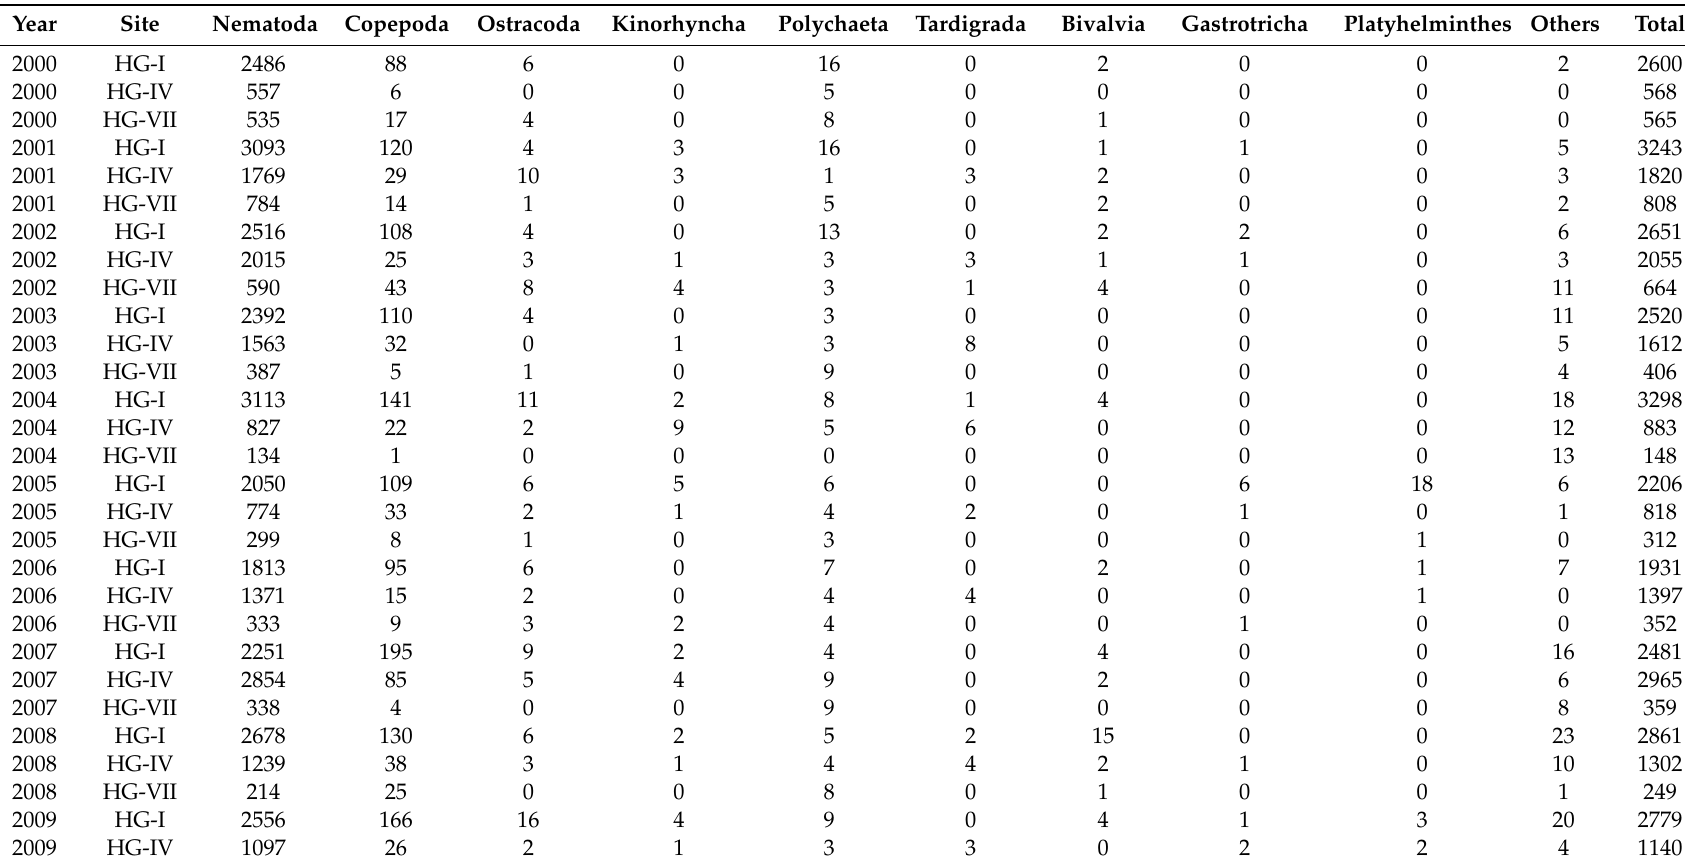
Table 2. Meiofaunal densities (ind. 10 cm − 2 ) at HAUSGARTEN sites HG-I, HG-IV, and HG-VII between 2000 and 2014 (Others: sum of all other taxa occurring in minor quantities; Total: total metazoan